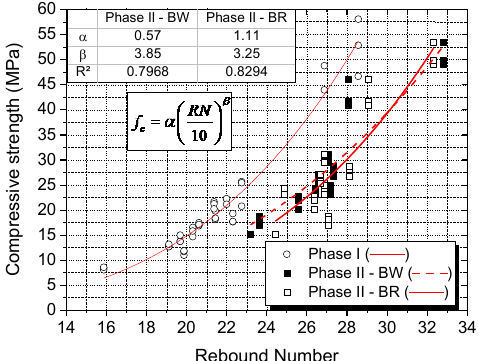
Figure 12 – Correlation between compressive strength and rebound number in phase II.